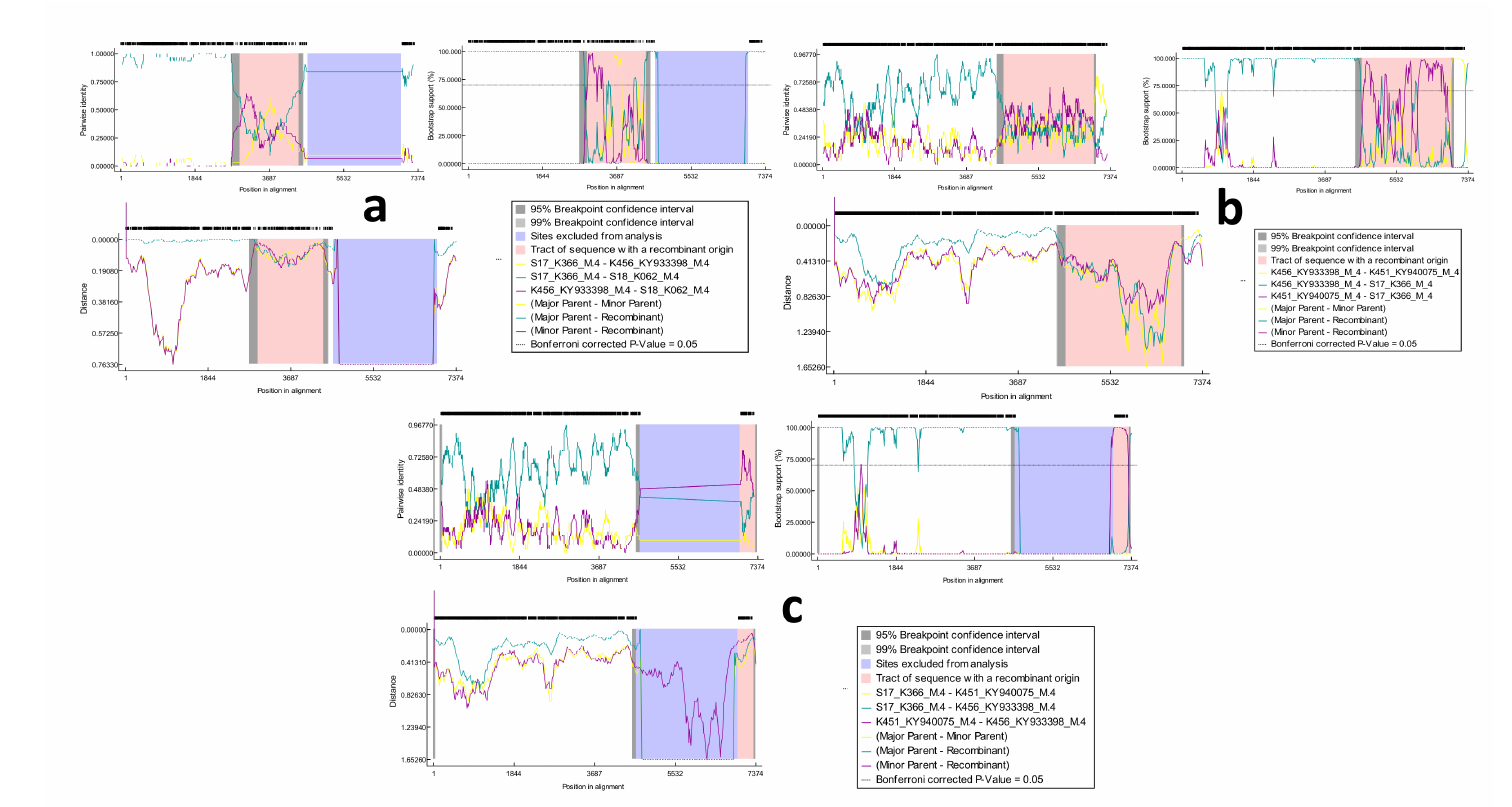
Figure 3. Recombination analysis of newly discovered full-length astrovirus genomes: ( a ) Predicted recombination event has likely occurred in the ORF1a–ORF1b junction and covers nearly the entire RdRp region. K062 strain is recombinant. ( b ) Predicted recombination event has likely occurred in RdRp–ORF2 overlap and covers almost the entire capsid region (ORF2); K366 is the recombinant. ( c ) Predicted recombination event has occurred in the 3 (cid:48) end of the capsid region ORF2; K456 strain is